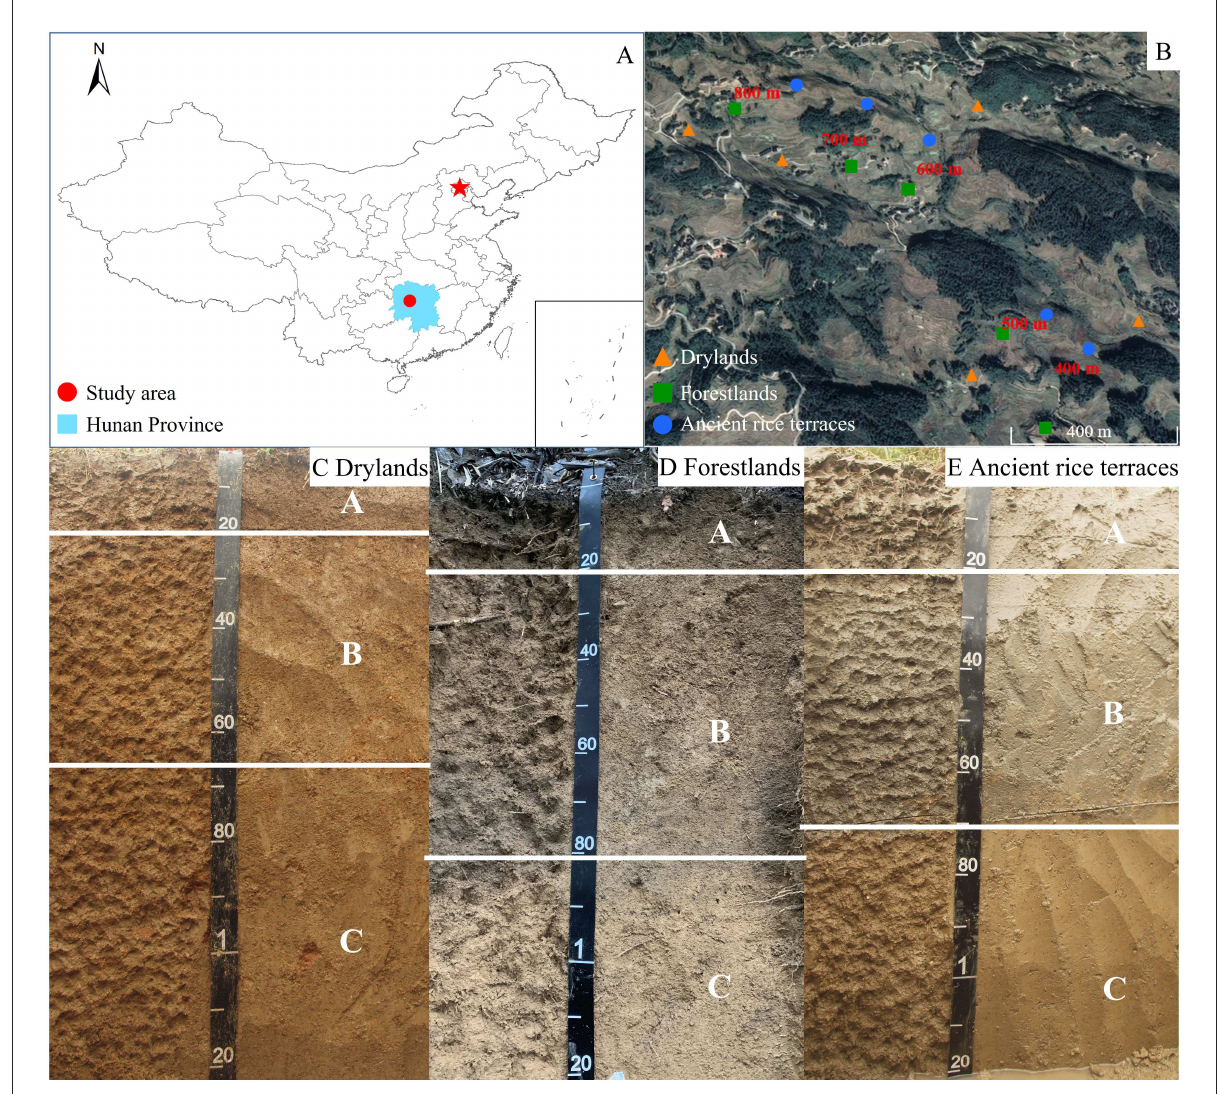
FIGURE1 The geographical location (A) , sample site distribution (B) , and soil profile (C–E) of the experimental plot.